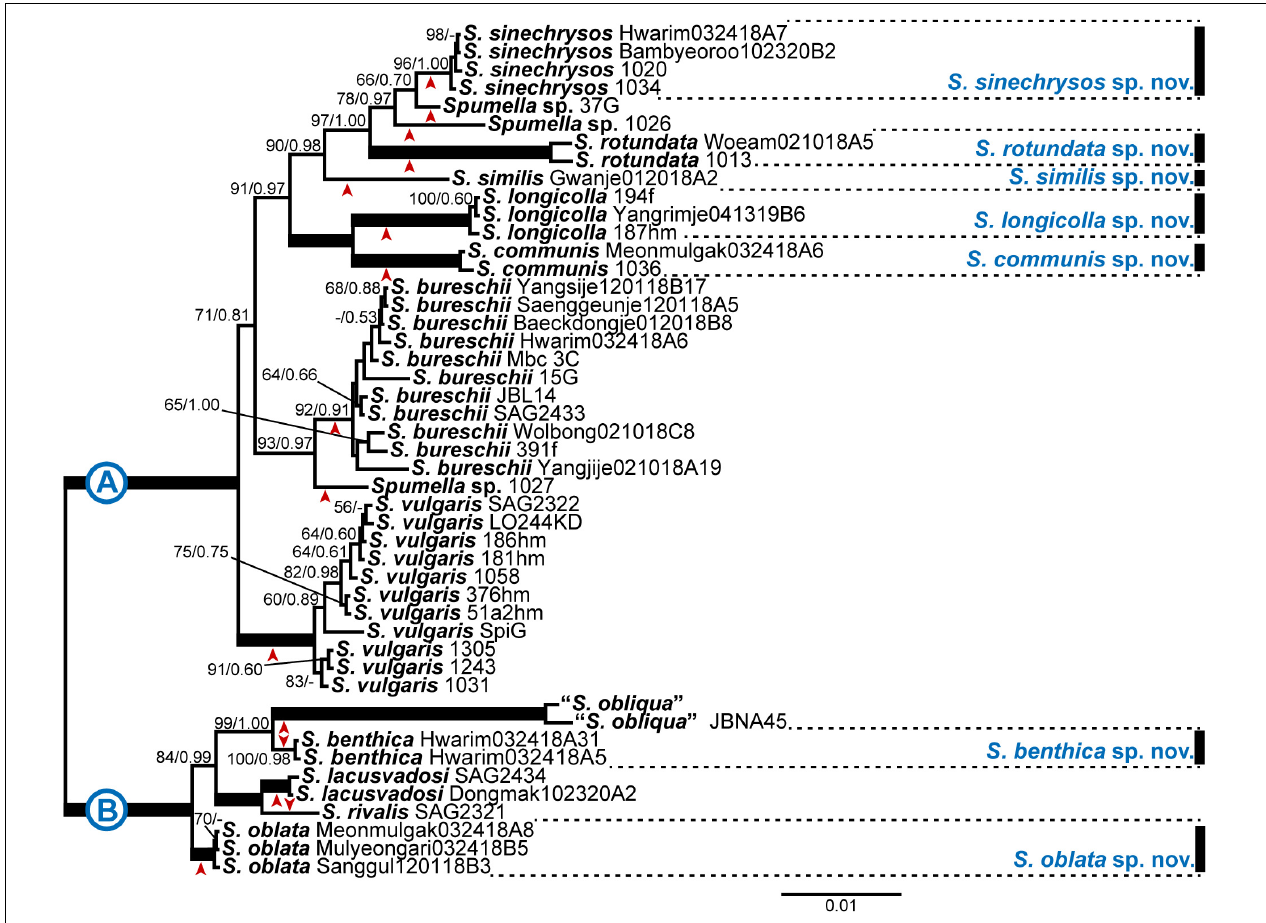
FIGURE 1 | Bayesian tree of the genus Spumella based on combined nuclear SSU and LSU rDNA and ITS sequence data. The maximum-likelihood bootstrap values (MLBS values, left) and Bayesian posterior probabilities (PPs, right) are shown at each node. The arrow head below or above each node indicates each lineage; the scale bar indicates the number of substitutions/site; the thick line indicates full support (100% MLBS and 1.00 PP), and (–) denotes values < 50% for MLBS or 0.50 for